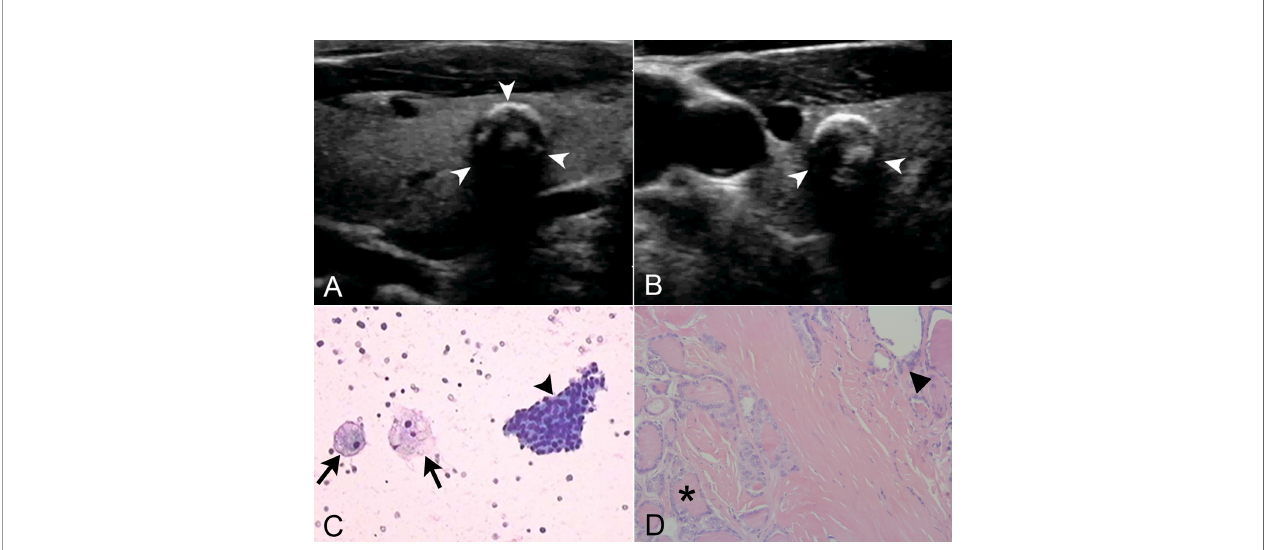
FIGURE 2 | The combined use of thyroid imaging reporting and data system (TIRADS), Bethesda System for Reporting Thyroid Cytopathology (BSRTC), and BRAF V600E mutation analysis in a 59-year-old man with 7.2 mm × 6.1 mm papillary thyroid microcarcinoma (PTMC). (A) Longitudinal ultrasound image showed a regularly shaped, indistinctly marginated, hypoechoic nodule with multiple macrocalci fi cations in the right lobe of the thyroid gland (arrow heads). (B) Transrectal ultrasound image more clearly showed the peripheral half ring-like macrocalci fi cations (arrow heads). (C) Cytological pathology showed nodular goiter with cystic change. Lamellar follicular epithelial cells (arrow head) and phagocytes (arrows) were seen, which was consistent with benign lesions (original magni fi cation, ×20). (D) Tumor cells were seen at the lower left (asterisk), and normal thyroid follicles were at the upper right (triangle). Tumor cells were ground glass-like with large and crowded nuclei (original magni fi cation, ×200). This nodule was classi fi ed as TIRADS 4a. The fi ne-needle aspiration (FNA) cytology result was categorized as BSRTC II, suggestive of a benign lesion. However, this nodule with negative cytologic result harbored the BRAF V600E mutation and proven to be PTMC